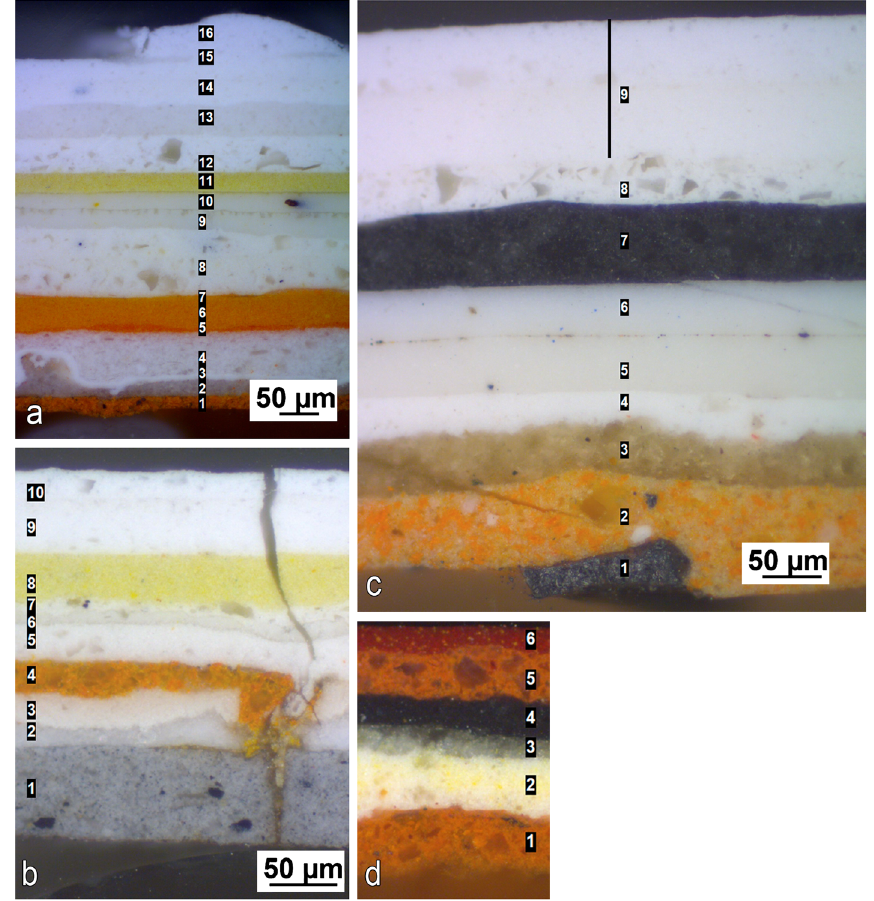
Figs. 24 Josef Frank and Oskar Wlach, Villa Beer in Vienna-Hietzing, 1930, paints on metal, sections of samples; binders: linseed oil or alkyd varnish. a: façade, main entrance, door frame metal, ‘ japan red ’ , 1: minium primer with some iron oxide red, 2: primer: chalk, zinc white or zinc siccative / drip nose, 3: titanium white KRONOS (?), Chalk, 4: titanium white (KRONOS), Silicates (fine sand), 5: lead chromate as bichromate, red, 6: lead chromate like (5), orange red. 7 – 16: later coatings. b: library, window frame, outside, gray, 1: zinc white, lead white, leg black, fine